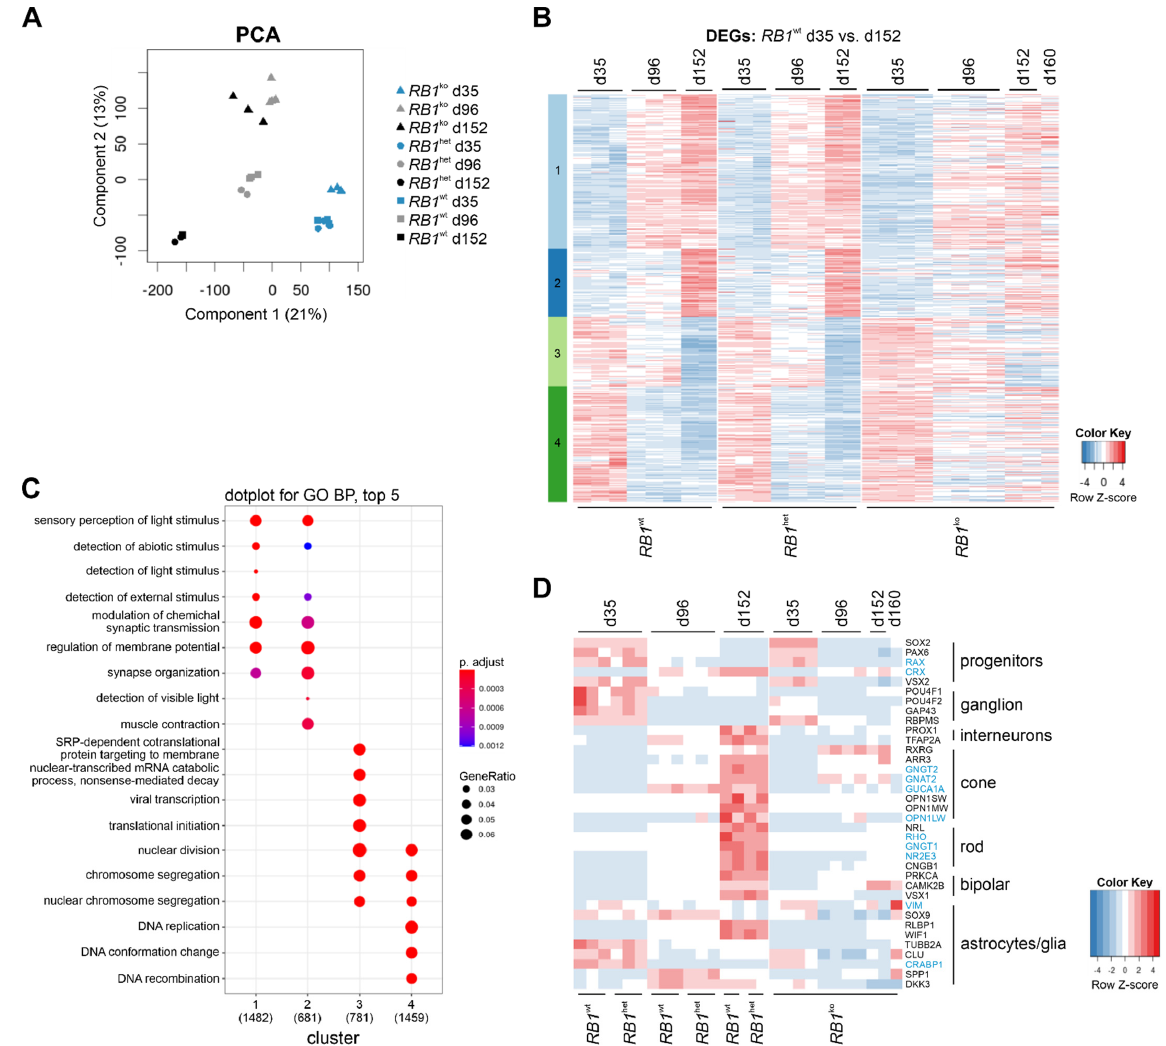
Figure 5. Transcriptome analysis revealed impaired retinal differentiation in RB1 ko after d35. ( A ) Principal component analysis. Color: time point (blue d35, grey d96, black d152), symbols: geno-